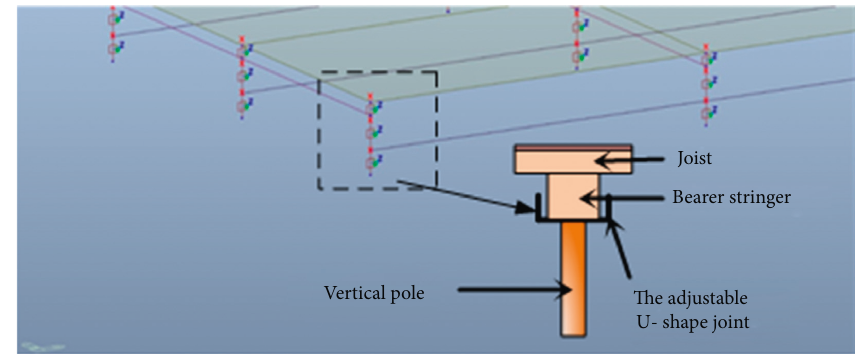
Figure 3: The load transfer path of the falsework